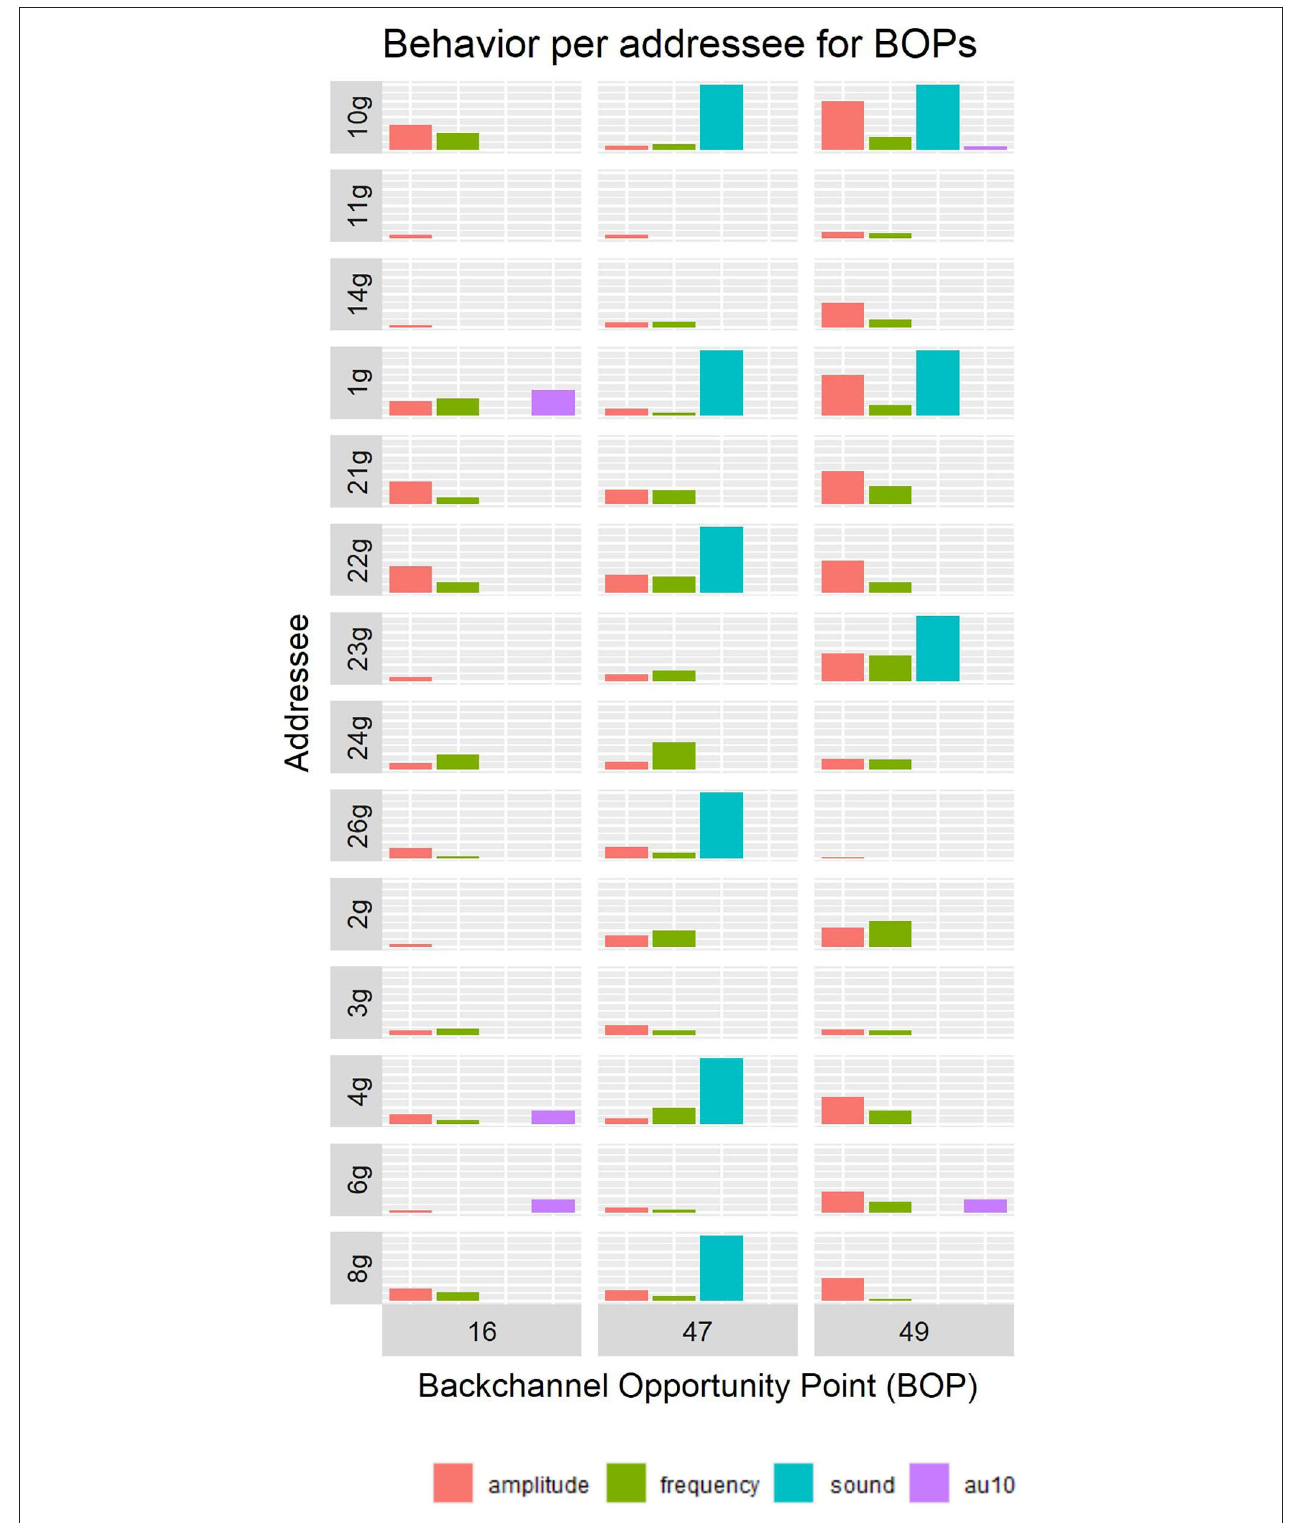
FIGURE 4 | Quantification of the feedback behavior of the original addressees during the BOP 16, 47, and 49.